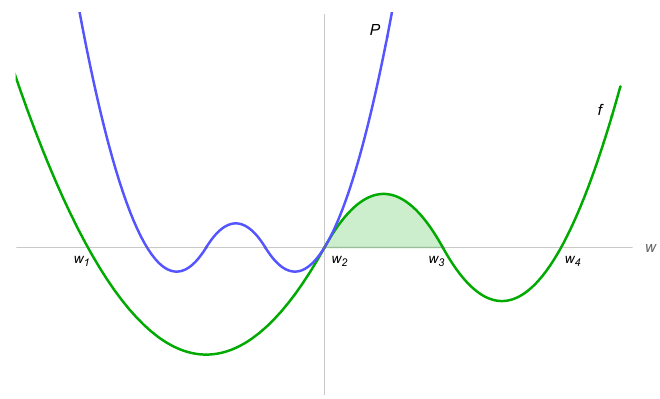
Figure 2 . A schematic plot showing the root structure of f ( w ) and P ( w ) such that we find a topo- logical disc. As before the shaded green region indicates the domain of w where the metric is